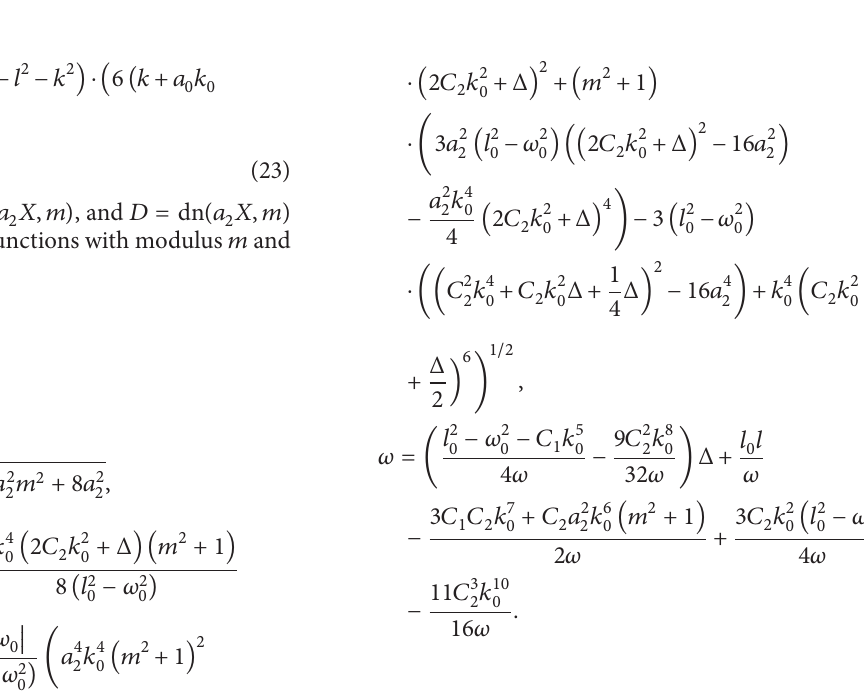
Figure 2: Plot of one soliton on the periodic cnoidal wave background expressed by (13). (a) The wave propagation pattern of the wave along 𝑡 axis at 𝑥 = 𝑦 = 𝑧 = 0. (b) The soliton-cnoidal wave structure at 𝑥 = 𝑦 = 𝑡 = 0. (c) The three-dimensional view at 𝑥 = 𝑦 = 0. (d) The density plot of the corresponding